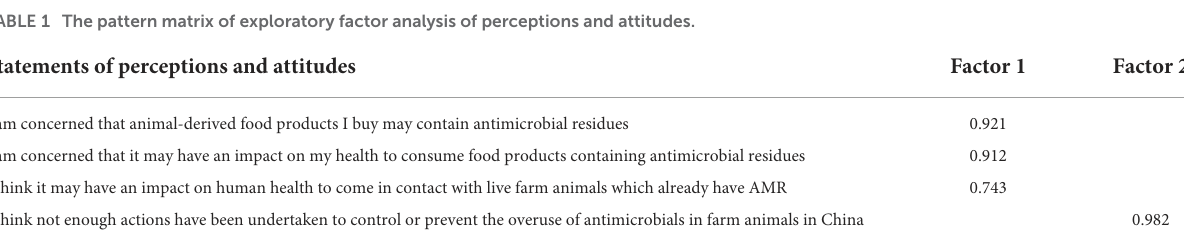
TABLE 1 The pattern matrix of exploratory factor analysis of perceptions and attitudes.